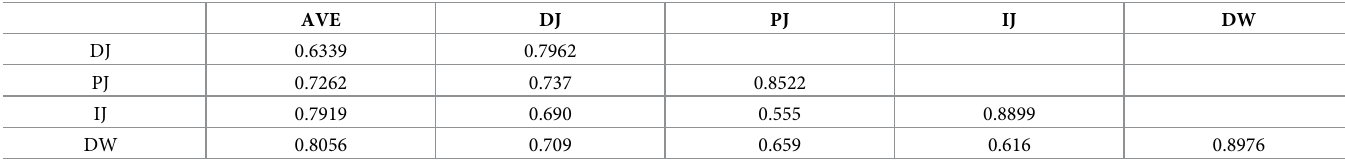
Table 8. Correlation coefficient of latent variables and AVE